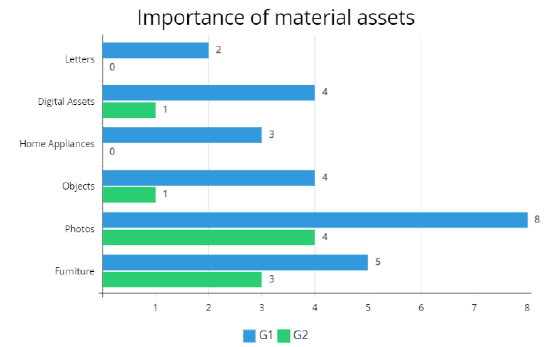
Figure 6. Which assets are more important ­ G1 and G2